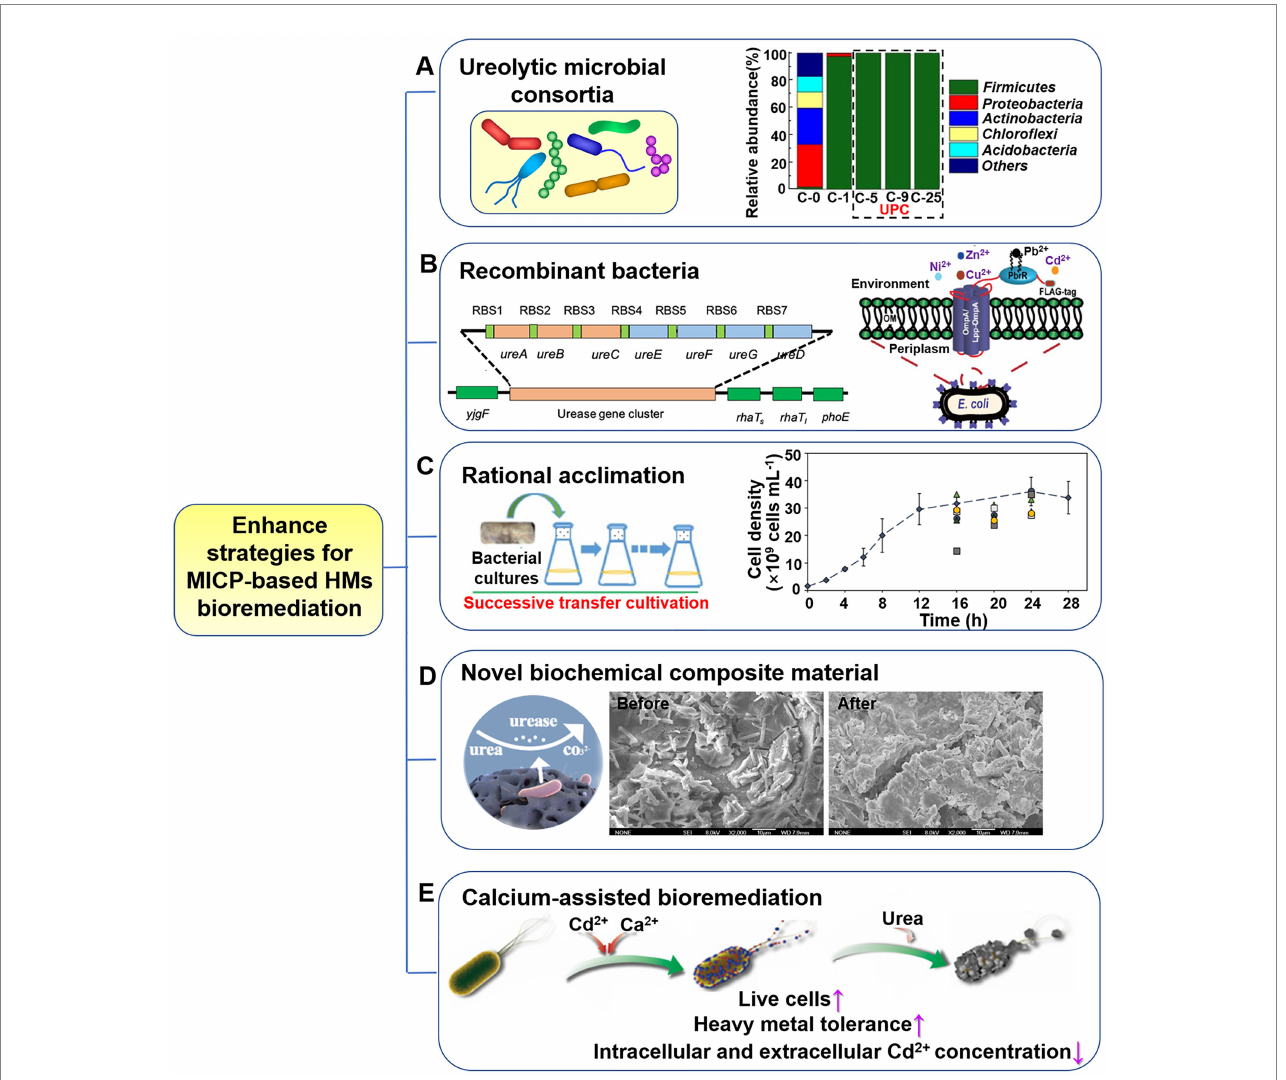
FIGURE 4 Enhancement strategies for ureolytic MICP-based heavy metals (HMs) bioremediation. (A) Ureolytic microbial consortia. Reproduced with permission from Yin et al. (2021a). (B) Recombinant bacteria. Reproduced with permission from Wei et al. (2014), Liang et al. (2018b). (C) Rational acclimation. Reproduced with permission from Oliveira et al. (2021) and Liang et al. (2018a). (D) Novel biochemical composite materials. Reproduced with permission from Song et al. (2021). (E) Calcium-assisted bioremediation. Reproduced from Fang et al.